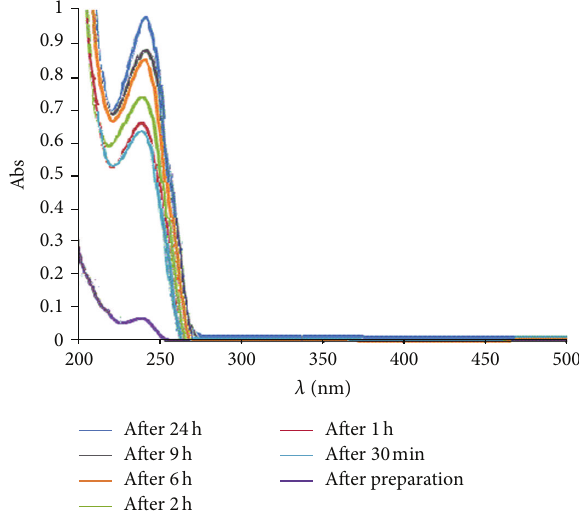
Figure 9: UV-Vis spectra of release of amoxicillin in SBF at the beginning and 30min, 1h, 2h, 6 h, 9 h, and 24h after the preparation of the suspension.